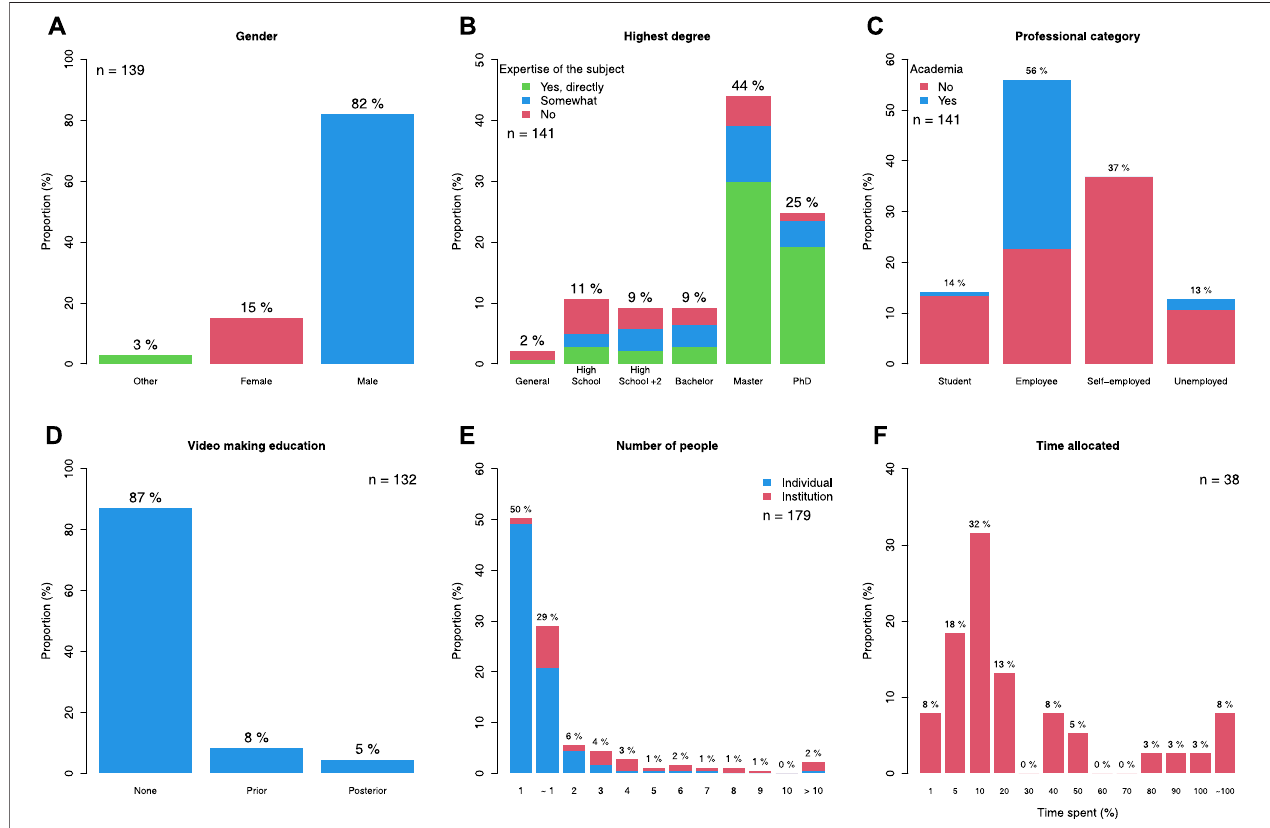
FIGURE 1 | Portrait of French science communicators on YouTube. (A) Gender representation of individual content creators. (B) Highest degree obtained by the individual communicators, strati fi ed by whether the topic of the degree relates to the topic of the channel (C) Professional category of individual content creators. Categoriesaremutuallynonexclusive.PhDstudentsareclassi fi edasemployees. (D) Proportionofindividualcommunicatorswithaformalvideomakingeducation,prior orposteriortotheirchannel ’ screation. (E) Numberofpeopleregularlyworkingonthechannel. ∼ 1:onepersonsometimesgettinghelpfromanotherperson. (F) For institutions only, percentage of time the employees devote to the channel. ∼ 100: multiple people devote the equivalent of a full-time job together.